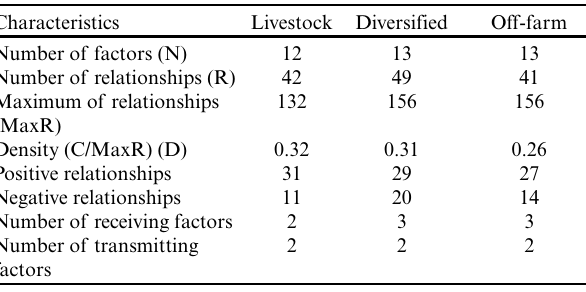
Table 5 . Key characteristics of the